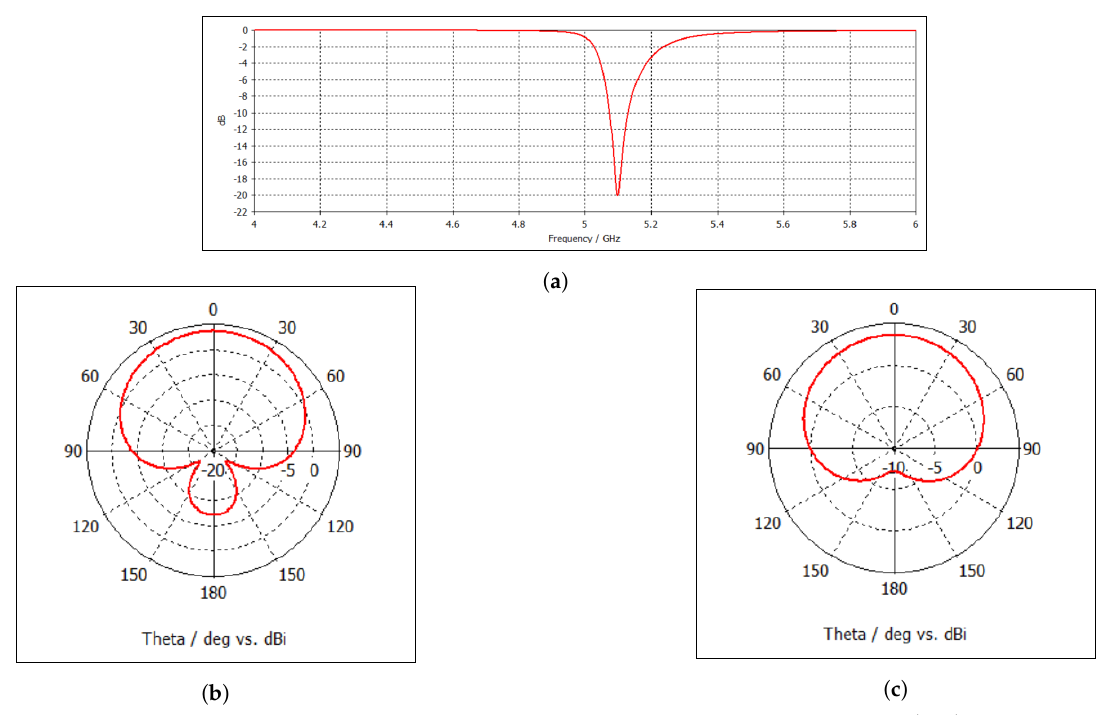
Figure 15. Linearly polarized Huygens antenna designed for 5.1 GHz in free space. ( a ) | S 11 | values as a function of the source frequency. Realized gain patterns (dBi) at 5.1 GHz with θ varying in the ( b ) E- and ( c ) H-